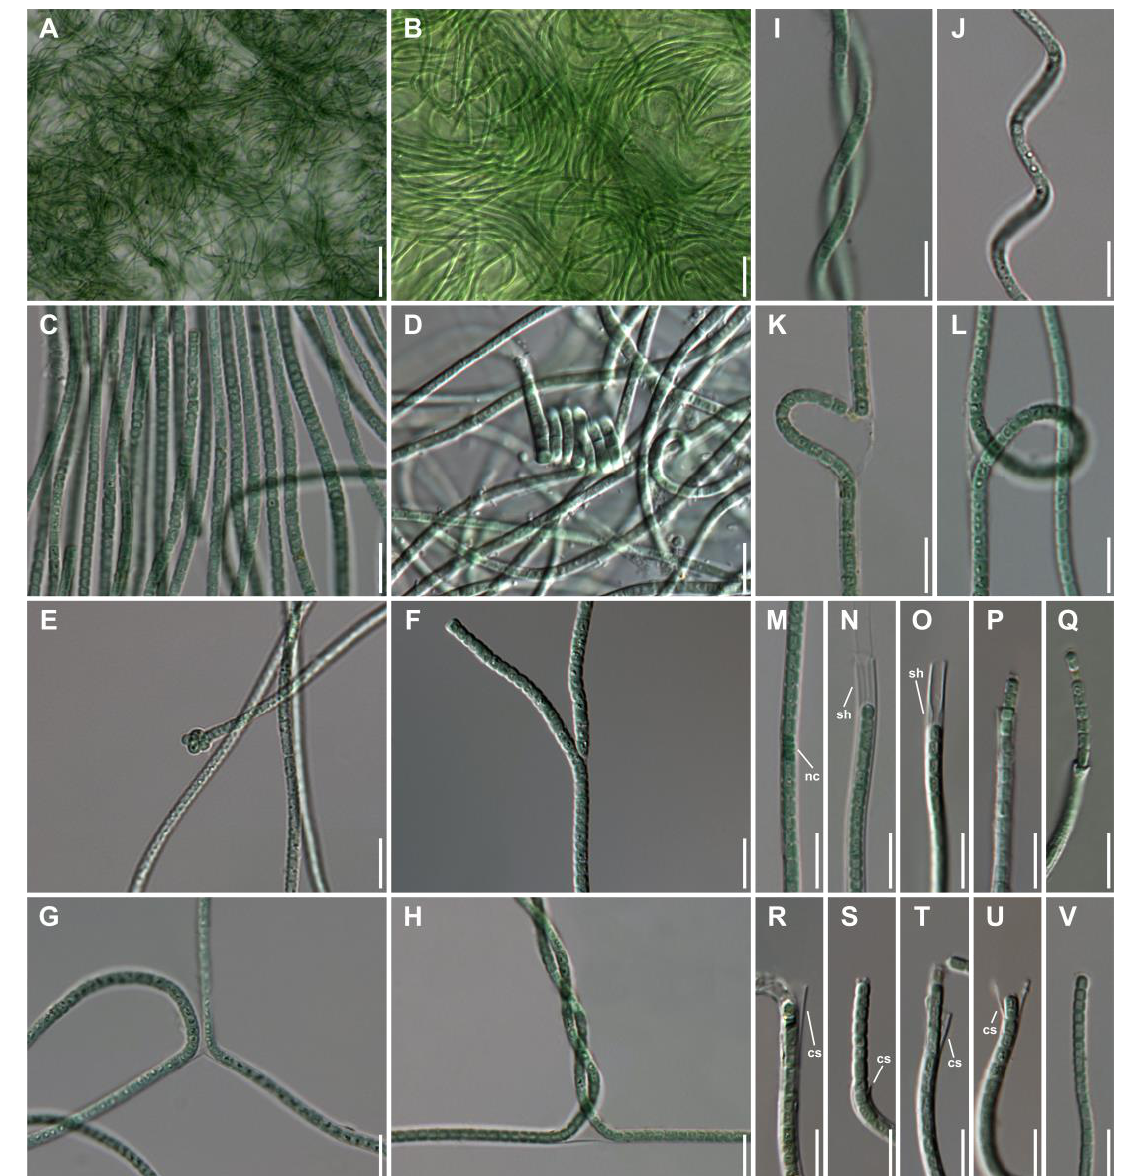
Figure 2. Light microscopic photographs of Trichotorquatus salinus , the culture sample from the reference strains (FBCC-A1483). ( A , B ) Entangled growth of the arrangement of trichomes; ( C ) Parallel trichomes; ( D ) Coiled trichomes; ( E ) Tangled apical cell; ( F ) Tolypothrix -type of false branched; ( G , H ) Scytonema -type of false branched; ( I , J ) Trichomes regularly or loosely spiralis; ( K , L ) Trichome broke out of the sheath (sh); (M) Trichome with necridia cell in rows; ( N , O ) Bulging within a sheath; ( P – U ) Collar sheath (cs) near trichome apices or a telescoping and persistent after trichome escapes from sheath; ( V ) Rounded apical cell. Scale bars, 50 μm ( A ); 20 μm ( B ); 10 μm ( C – V ).